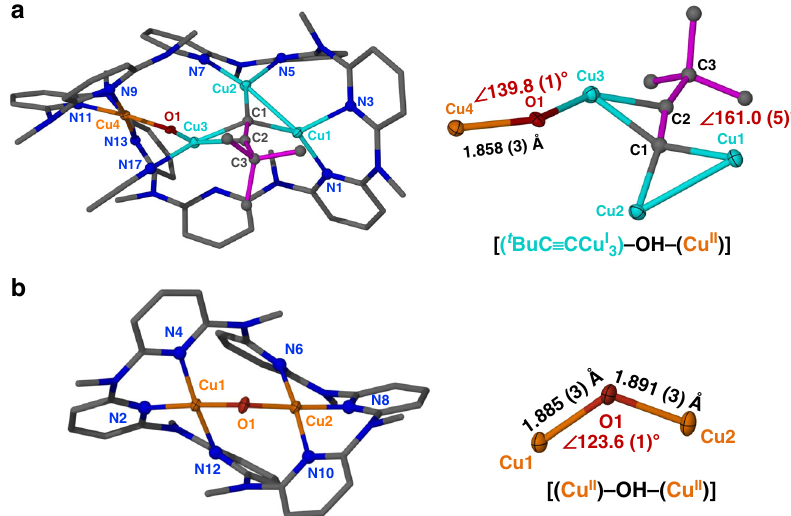
Fig. 2 Molecular structures of 1 and 2 . Crystal structures and the cluster cores of a complex 1 and b complex 2 with partial atom labeling (50% thermal ellipsoid probability level). Hydrogen atoms, BF 4 − anions, water and solvent molecules are omitted for clarity. Selected bond lengths and distances (Å) of 1